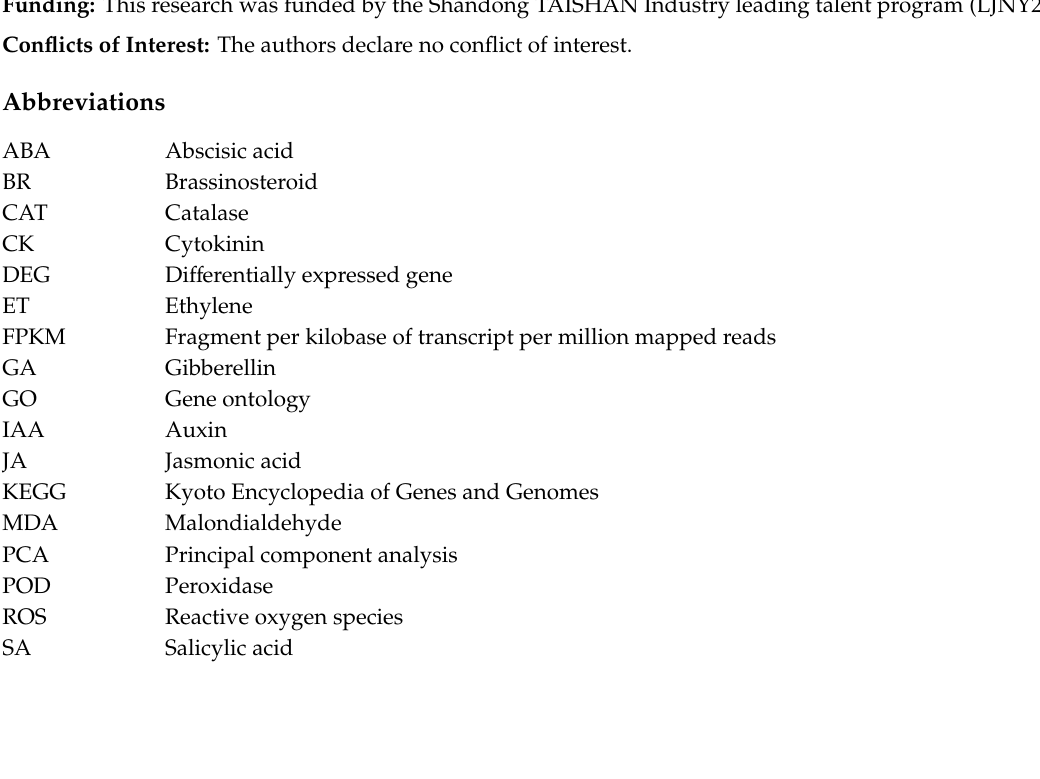
Supplementary Materials: Supplementary materials can be found at http: // www.mdpi.com / 1422-0067 / 21 / 14 / 5095 / s1. Table S1: New genes, Figure S1: Pearson correlation coe ffi cient analysis of transcriptome data from cotyledons of two cotton varieties at di ff erent time points under chilling stress, Table S2: Significant GO-terms in YM21 and H559 before cold stress, Table S3: Significant GO-term enrichment of four significant WGCNA modules, Figure S2: Coexpression network construction of green module, Figure S3: Coexpression network construction of paleturquoise module, Table S4: Transcription factor genes in four significant WGCNA modules, Table S5: Primer sequences used in qRT-PCR, Figure S4: Clustering heatmap of the hub gene expression levels revealed using RNA-seq and qRT-PCR. All authors have read and agreed to the published version of the